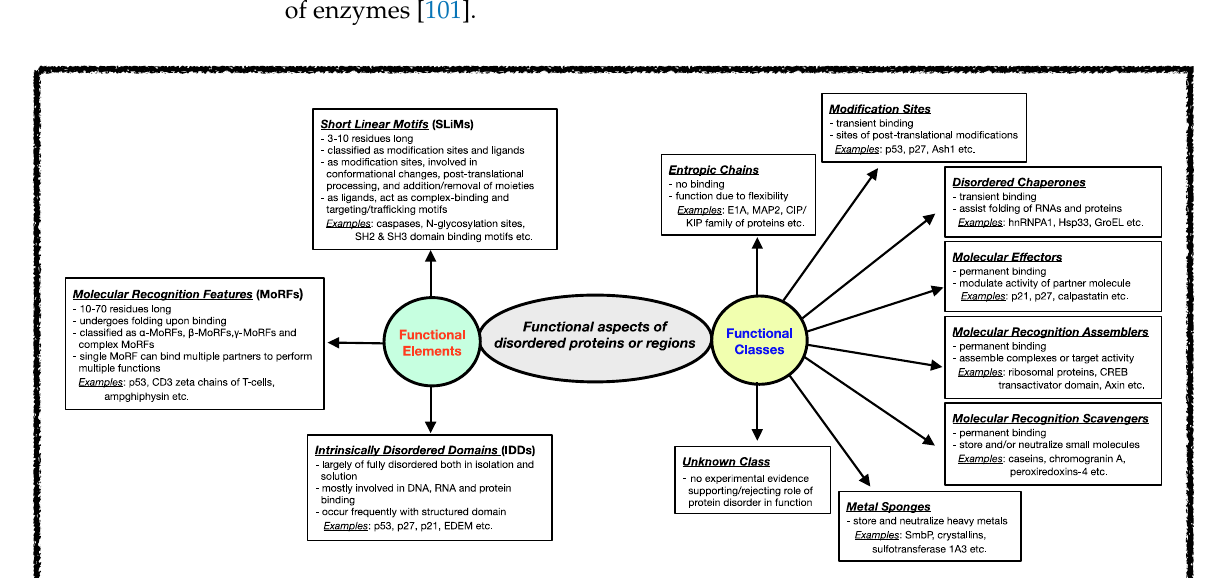
Figure 2. Functional aspects of IDPs/IDRs. Intrinsically disordered proteins/regions’ functional classes and elements are described here. The functional class scheme describes eight different categories into which IDPs/IDRs can be grouped based on their biological function. The different functional classes include Entropic chains, Modification sites, Disordered chaperones, Molecular effectors, Molecular recognition assemblers, Molecular recognition scavengers, Metal sponges, and Unknown. IDPs/IDRs’ functions are mediated mainly through three types of structural elements, namely Short Linear Motifs (SLiMs), Molecular Recognition Features (MORFs), and Intrinsically Disordered Domains